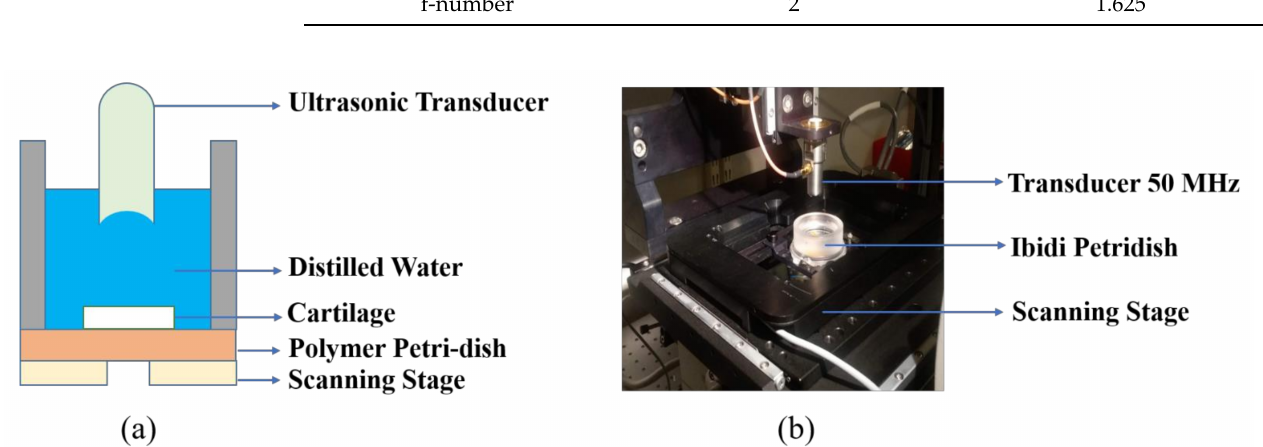
Figure 4. ( a ) Schematic diagram of our setup with ultrasonic transducer kept above the cartilage in Petri dish. ( b ) Camera view of our setup showing transducer, Petri dish, and scanning